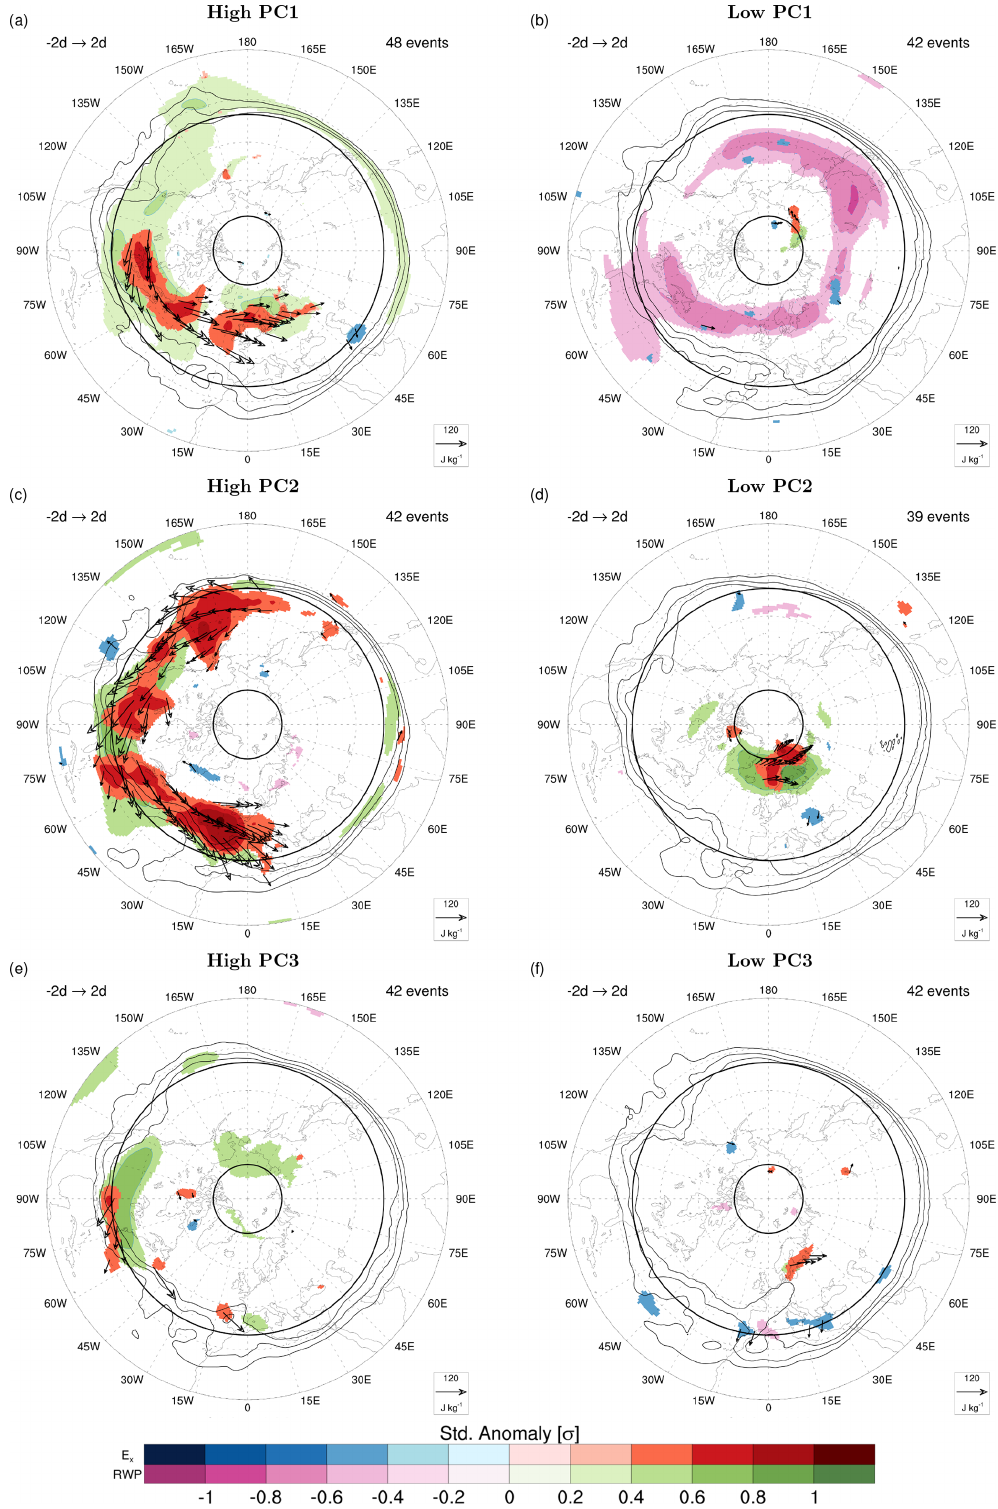
Figure 4. Composites of pentad-mean standardized anomalies of E x and logarithm of RWP amplitude at t max of events respectively in the top and bottom 15% of (a, b) PC1, (c, d) PC2 and (e, f) PC3. Only significant standardized anomalies ( p < 0 . 01) are shown, as well as composite E vectors (black arrows) emanating from areas of significant E x anomalies. Bold black latitude circles indicate 35 and 75 ◦ N. The composite of PV at 250hPa is overlaid (black contours; only 1, 1.5 and